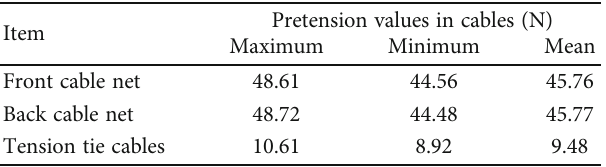
Table 1: Pretension distribution of the cable net. Item